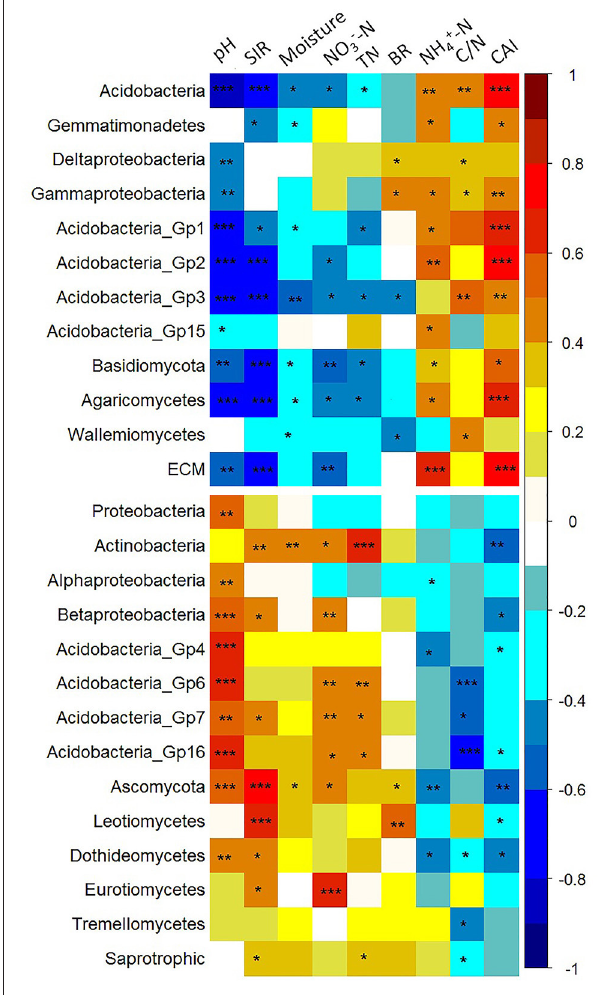
FIGURE 7 | Pearson’s correlation coefficients between the relative abundances of specific microbial taxa and the selected soil properties. The correlation coefficients ranging from negative to positive are indicated by color intensity changing from dark blue to red, as illustrated by the figure legend. In general, it was shown that the relative abundances of the so-called “oligotrophic” microbial groups (located at the upper panel) showed positive correlations with NH + 4 -N, C/N and CAI (covered by orange to red color), but negative correlations with TN, NO − 3 -N, moisture content, SIR and pH (covered by cyan and blue color). In contrast, the relative abundances of the “copiotrophic” members (the lower panel) demonstrated the reverse patterns. *0.01 < P < 0.05, **0.001 < P < 0.01, *** P < 0.001.